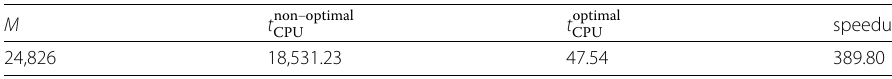
Table 7 Preliminary results with N = 256, K y = K z = 3 for Example 3 M